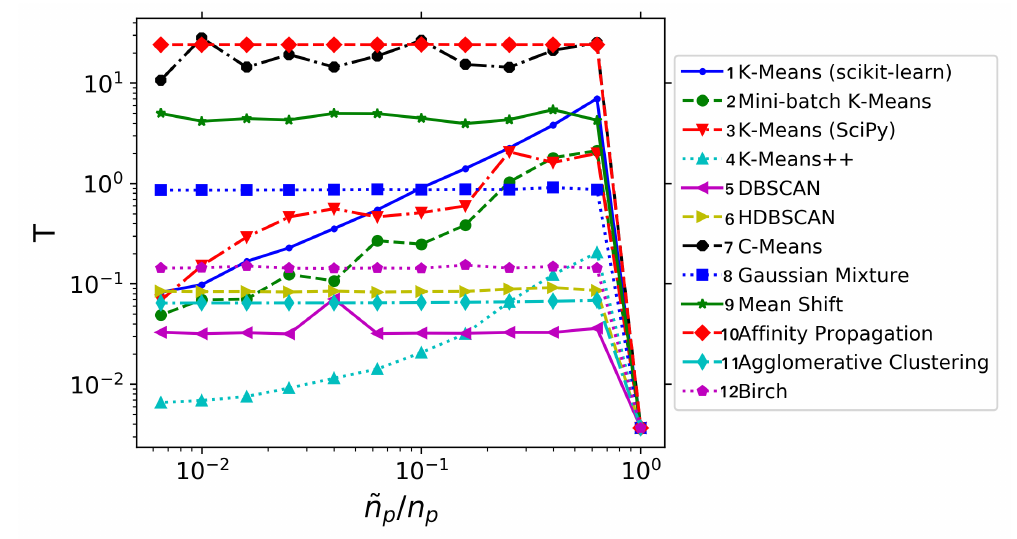
Figure 4. Synthetic system: Average time consumption (in seconds) for different clustering algorithms.